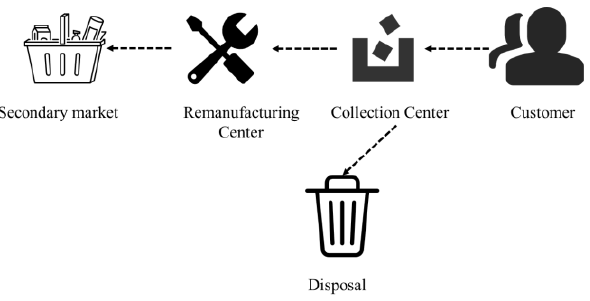
Figure 1. General network structure.